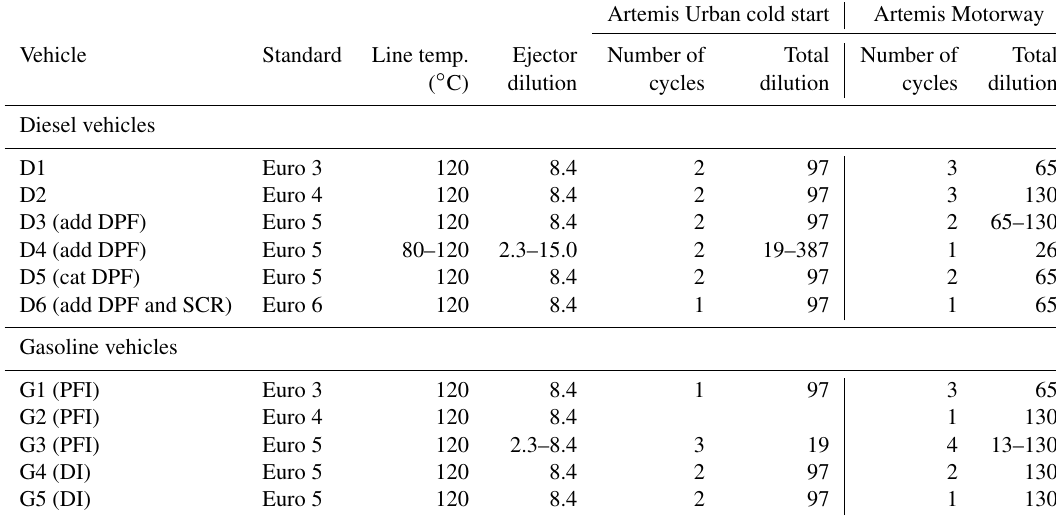
Table 4. Summary of the conditions for the diesel and gasoline experiments. Artemis Urban cold start Artemis Motorway Vehicle Standard Line temp. Ejector Number of Total Number of Total ( ◦ C) dilution cycles dilution cycles dilution Diesel vehicles D1 Euro 3